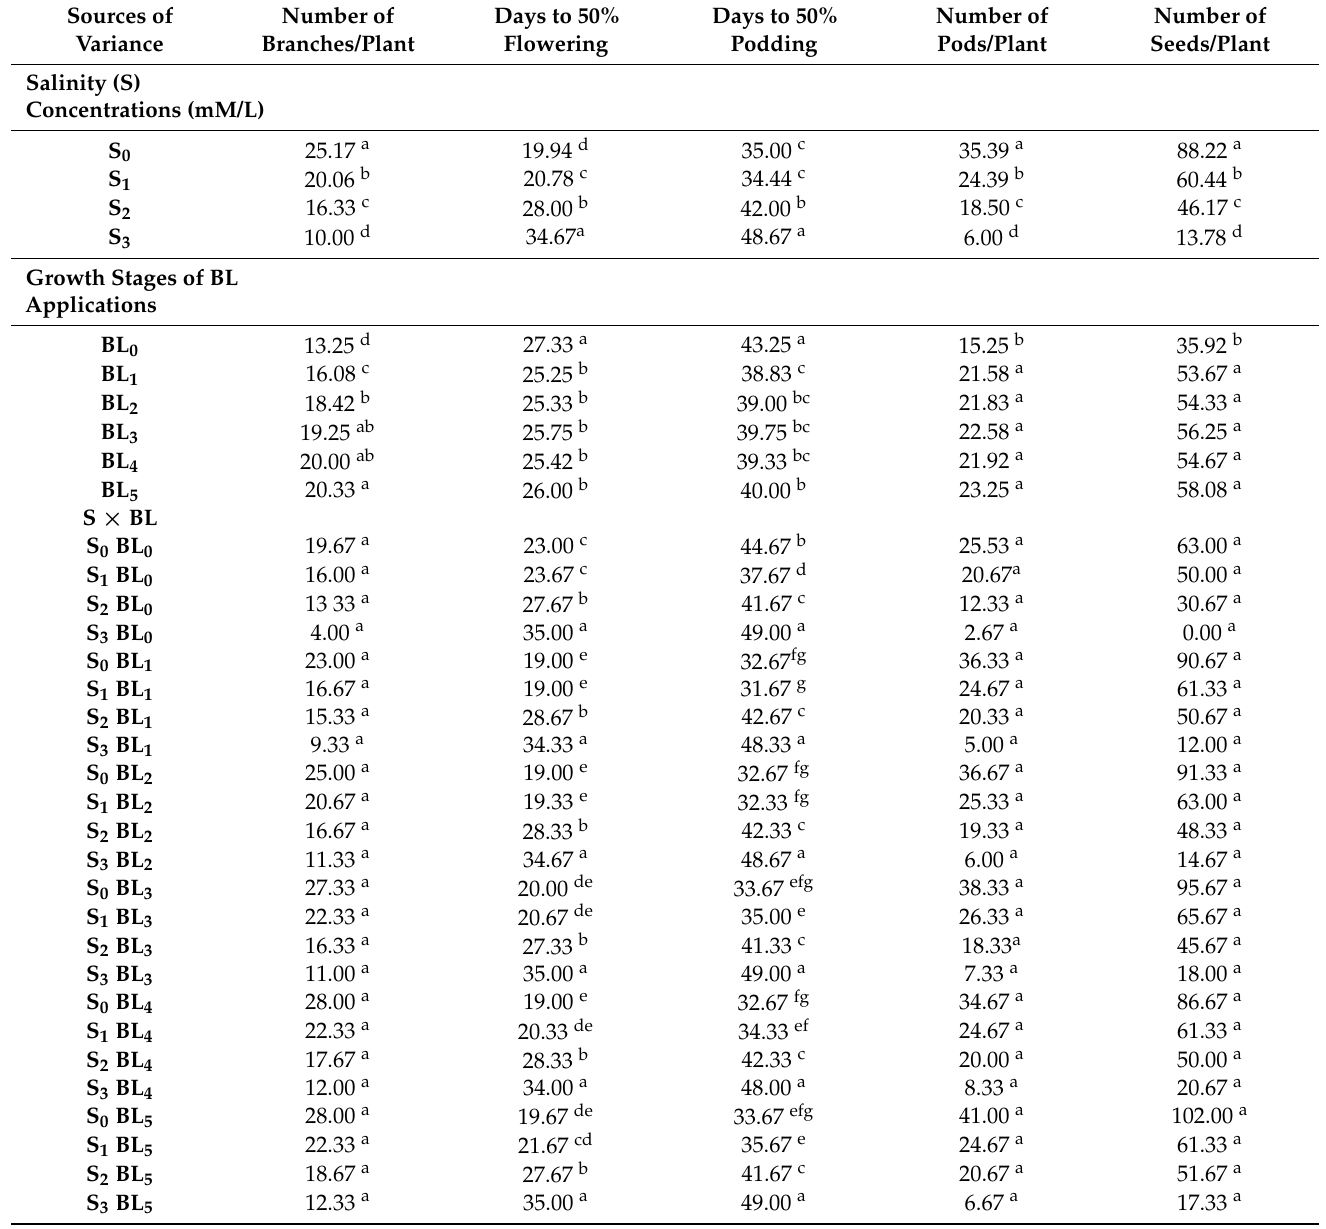
Table 4. Main and interaction effects of salinity (S) and brassinolide (BL) on number of days to 50% flowering and podding of soybean and number of branches, pods and seeds per plant at harvest. Sources of Number of Days to 50% Days to 50% Number of Number of Variance Branches/Plant Flowering Podding Pods/Plant